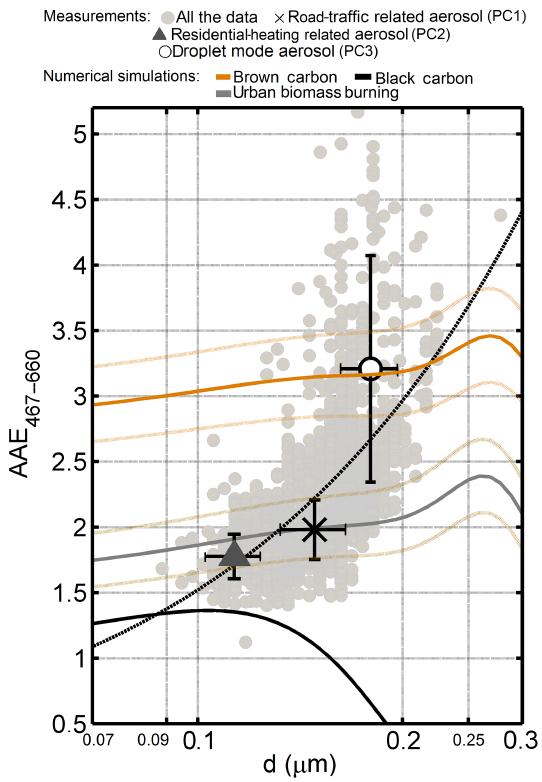
Figure 1. Experimentally measured and numerically simulated (Mie theory) relation between absorption Ångström exponent (AAE) at 467–660nm and aerosol size ( d ). For measurements, (i) d is represented by the mobility median diameter of the PM 10 particle surface size distribution ( d med (S) ); (ii) all the data measured are in- dicated by light grey markers, the dotted black line representing the best fit to these data; (iii) major aerosol types identified (Sect. 3.3) are indicated by darker markers (median ± standard deviation). For numerical simulations (Sect. 3.4), patterns theoretically expected for BrC, BC, and urban biomass burning are indicated by brown, black, and grey thick lines, respectively, the dotted thinner lines in- dicating the uncertainty of the refractive index ( m (λ) = n (λ) − ik (λ) ) set to ± 0.01 for n (λ) and ± 0.001 for k (λ) ).